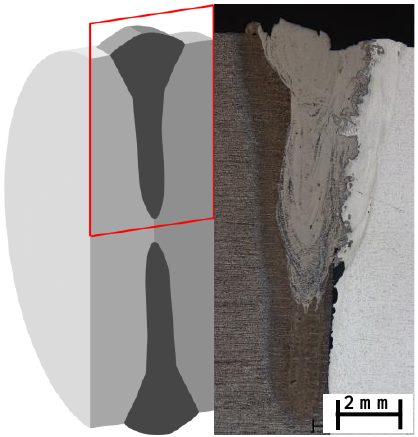
Figure 3. Zoomed part from Figure 1b and a corresponding micrograph of a metallographic cross section of a steel-aluminium alloy weld.